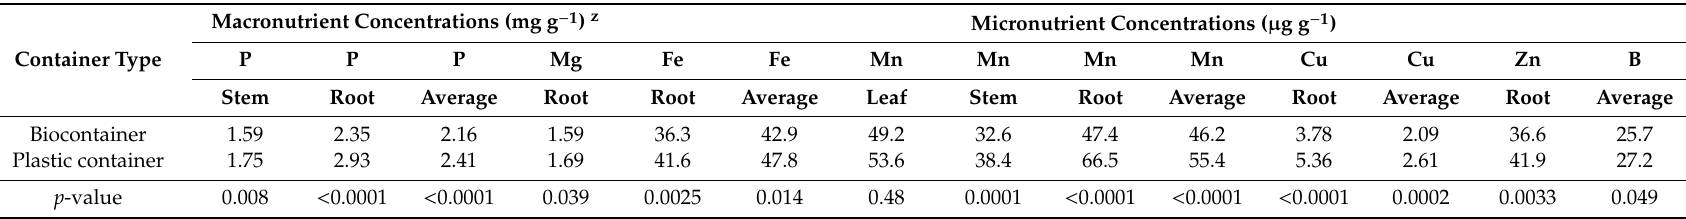
Table 1. Container type a ff ects concentrations of macro- and micro-nutrients in leaves, stems, roots, or averaged in the plant of H. macrophylla ‘Merritt’s Supreme’.